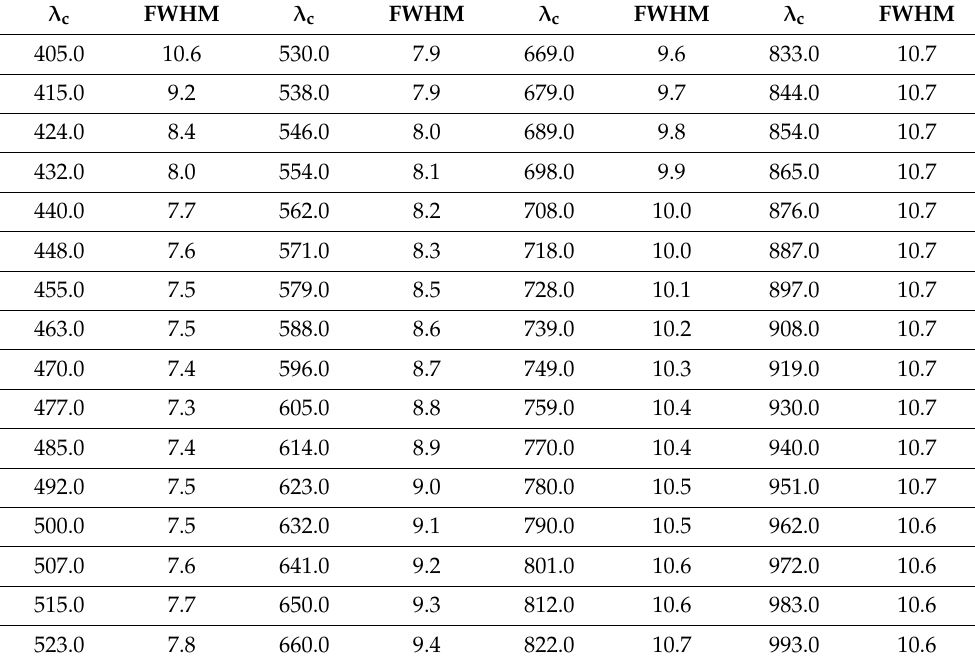
Table 1. Characteristics of simulated bands. The channels’ central wavelength ( λ c ) and FWHM were chosen to be representative of existing hyperspectral sensors; in this case, the simulation mirrored the ASI sensor PRISMA bands in the 400–1000 nm range. Values are reported in nanometers. λ c